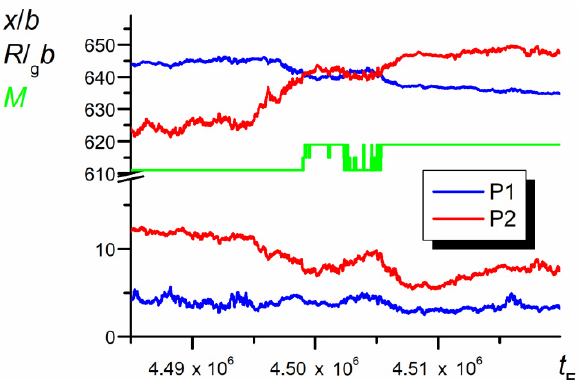
Figure 12. Short parts of trajectories of s P1 and P2 and their radii of gyration ( N = 100, ε PP / k B T = − 1 and 0 for P1 and P2, respectively, D = 3 b ). The chart is based on the data recorded at each elementary step, t E .